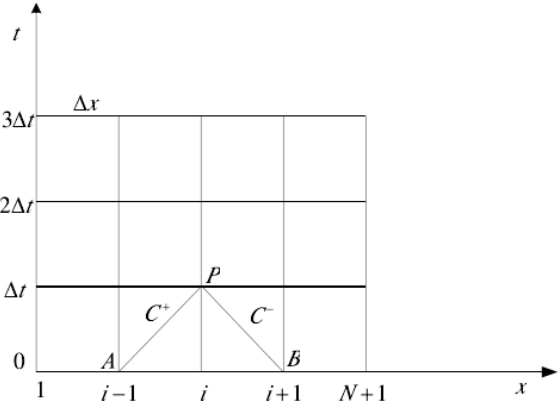
Figure 2. x - t characteristic line difference mesh.